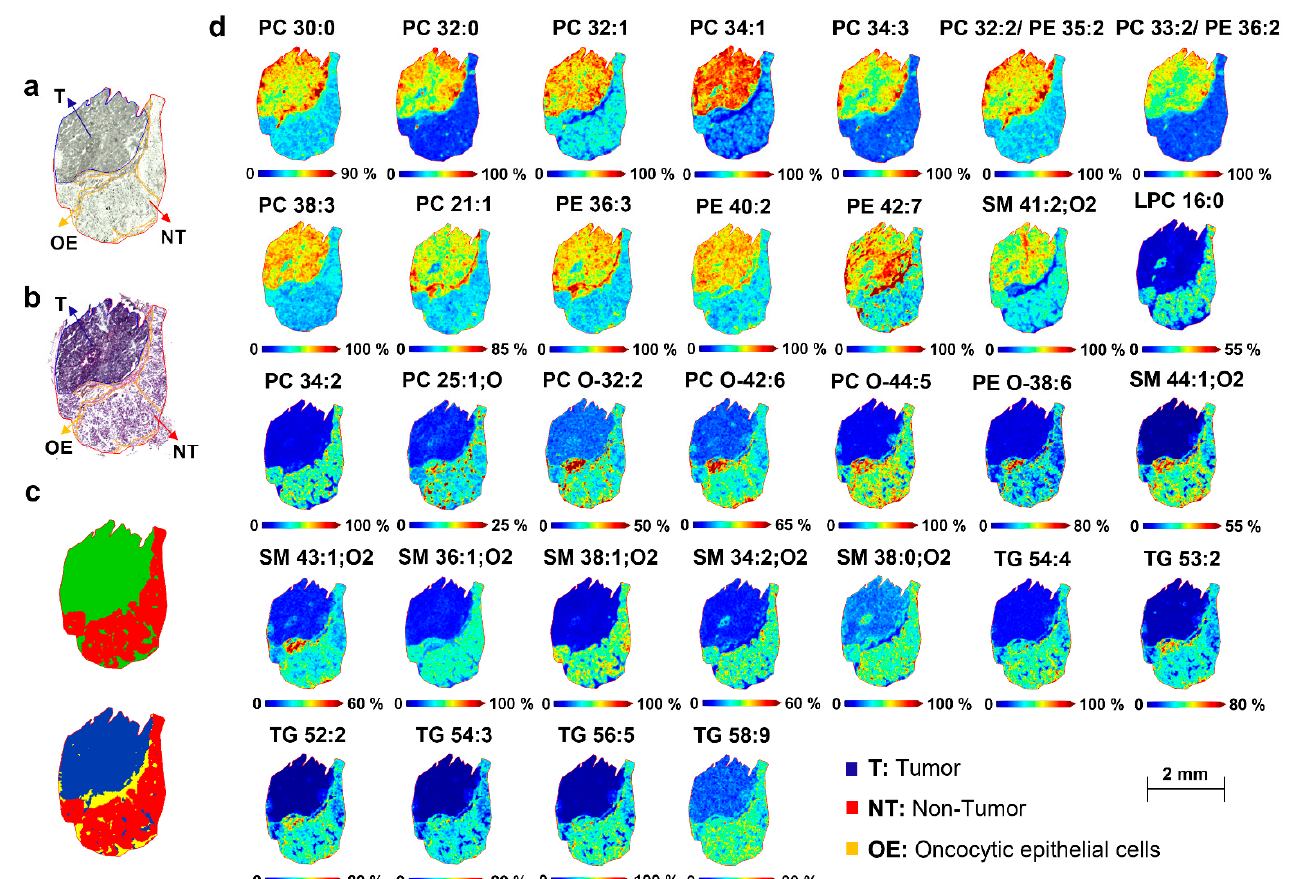
Figure 3. Molecular distribution of lipid species between the tumor and healthy regions of patient- derived parotid sections. ( a ) Optical image and ( b ) Hematoxylin and Eosin (H&E) image of parotid tissue with the pathologist’s annotation of the regions. ( c ) Bisecting the K-means segmentation map generated from the MALDI-positive TOF-MSI dataset. ( d ) MALDI-MS images of relevant lipids measured in positive ion mode, comparing the distribution between tumor and healthy regions of the parotid tissue. [PC 30:0+K] + , m/z 744.49; [PC 32:0+K] + , m / z 772.59; [PC 32:1+K] + , m/z 770.55; [PC 34:1+K] + , m/z 798.54; [PC 34:3+H] + , m/z 756.56; [PC 32:2 or PE 35:2+H] + , m/z 730.53; [PC 33:2 or PE 36.2+H] + , m/z 744.57; [PC 38:3+H] + , m/z 812.62; [PC 21:1+H] + , m/z 578.41;